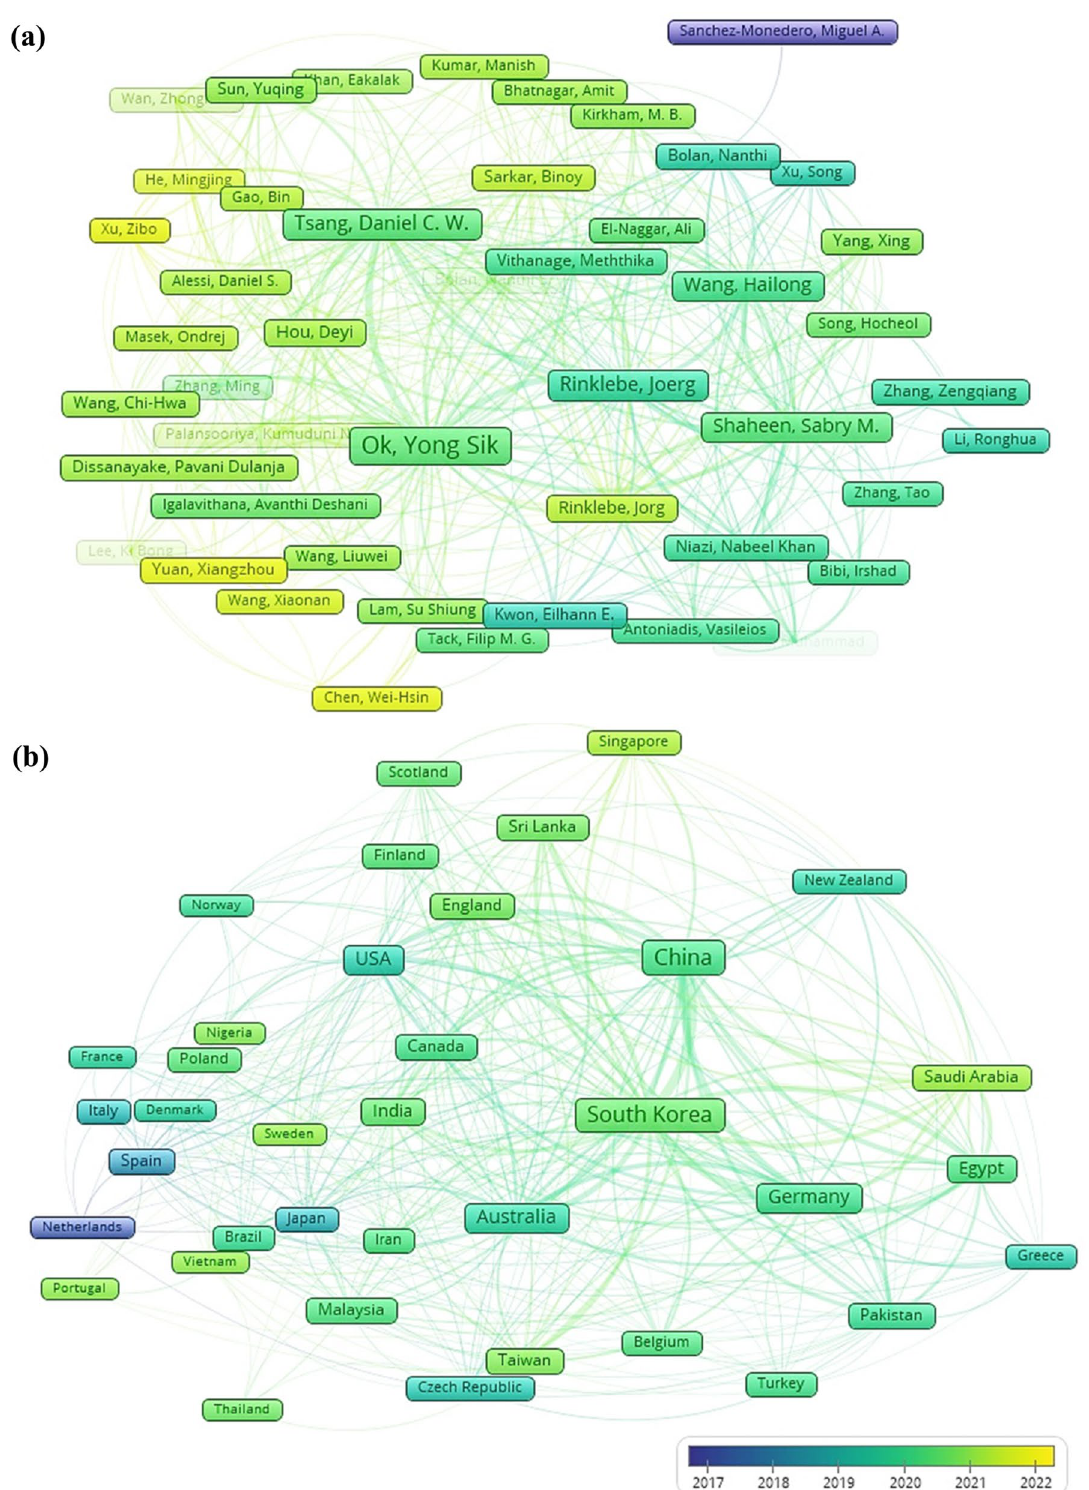
Fig. 2 Bibliometric network for waste management between a authors and b countries at minimum 10 document